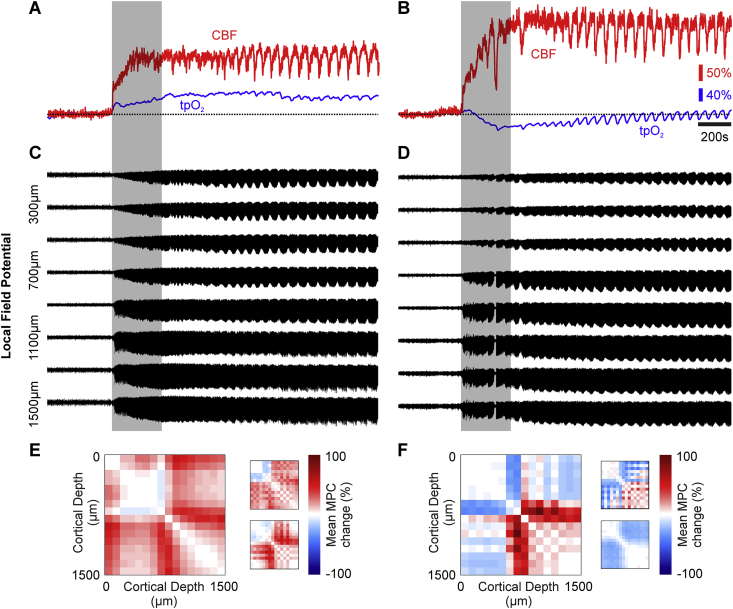
tpO2, CBF, laminar LFP activity and mean phase coherence (MPC) changes in two contrasting cases. A) Percentage changes in CBF (red) and tpO2 (blue) in an animal where tpO2 increases after seizure onset. B) Percentage changes in CBF (red) and tpO2 (blue) in a different animal where tpO2 decreases after seizure onset despite a marked rise in CBF. C) Associated laminar LFP recordings in same animal as A, showing strong activation in superficial depths. D) Laminar LFP recordings from same animal as B, showing comparatively weaker activation in superficial depths. E-F) Time-averaged normalized phase coherence matrices during seizure onset (300s, shaded bar in A-D) showing increases (red) and decreases (blue) in mean phase coherence (MPC) between electrode channel pairs. MPC matrices are symmetric about the diagonal. Left-hand matrix in E and F are from animals as in A, and B, respectively, with insets from two other representative animals with associated tpO2 increases and decreases, respectively.